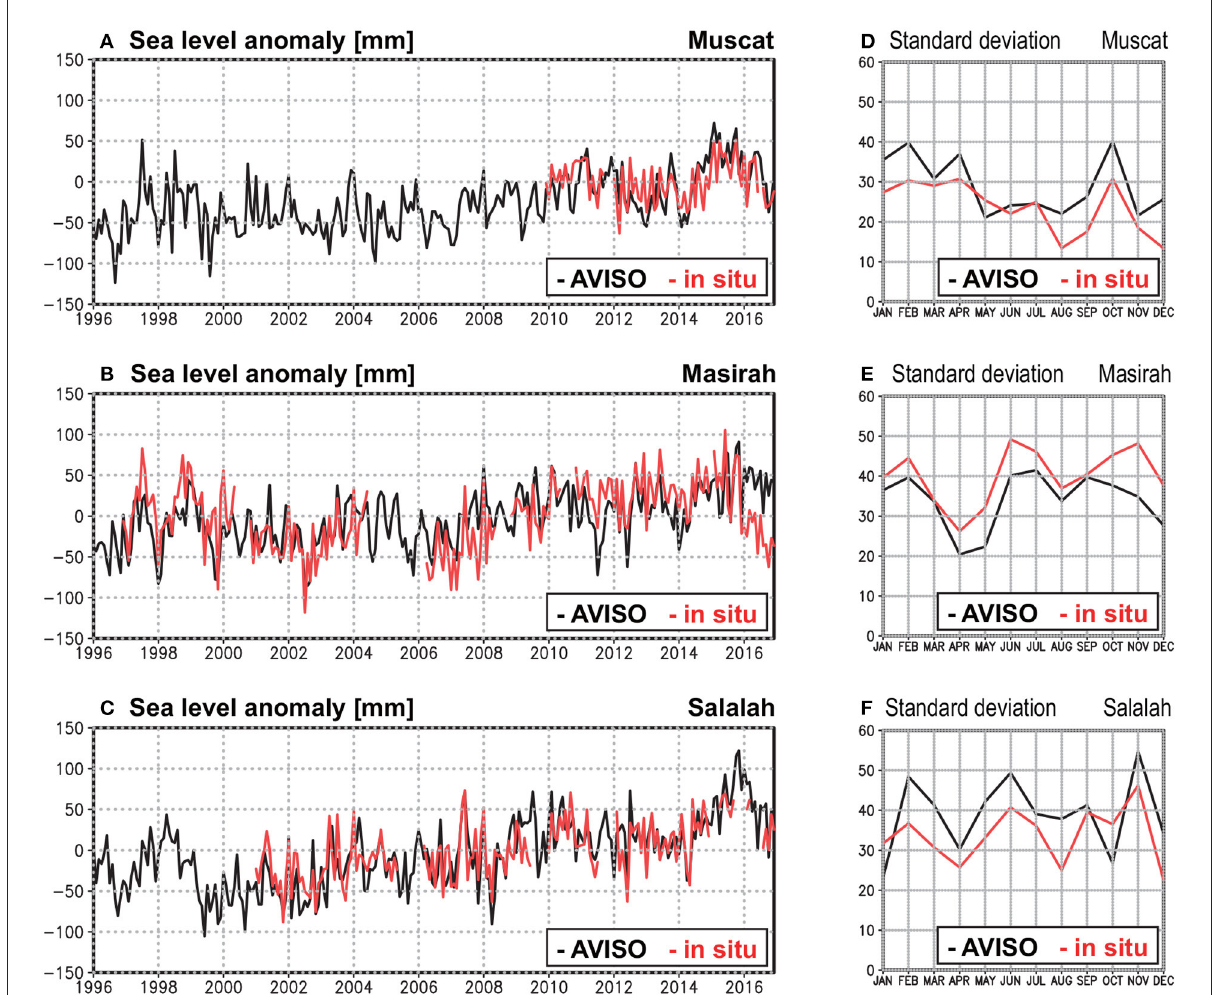
FIGURE1 (Left) Monthly anomalies of the observed sea level data at (A) Muscat B (23.6 ◦ N, 58.6 ◦ E), (B) Masirah (20.7 ◦ N, 58.9 ◦ E), and (C) Salalah (16.9 ◦ N, 54.0 ◦ E) observatories. Red and black lines represent in situ and AVISO satellite observations, respectively. (Right) Standard deviations of the observed sea level fluctuations for each calendar month at (D) Muscat B, (E) Masirah, and (F) Salalah observatories. For both the in situ (red lines) and satellite (black lines) observations, standard deviation values are calculated using the data in the period when the in situ data are